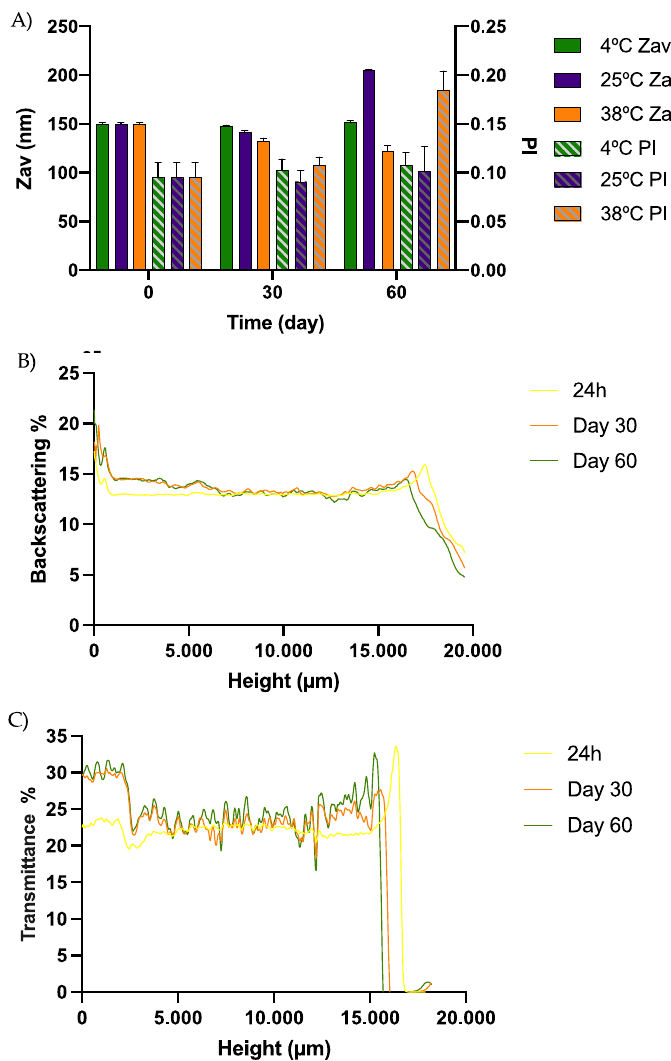
Figure 5. ( A ) Graphic representation of the physicochemical characterization at different storage temperatures (Z av and PI at 4, 25 and 38 °C), ( B ) Turbiscan backscattering profile at 4 °C of DCF NPs, ( C ) Turbiscan Transmittance profile at 4 °C of DCF NPs.